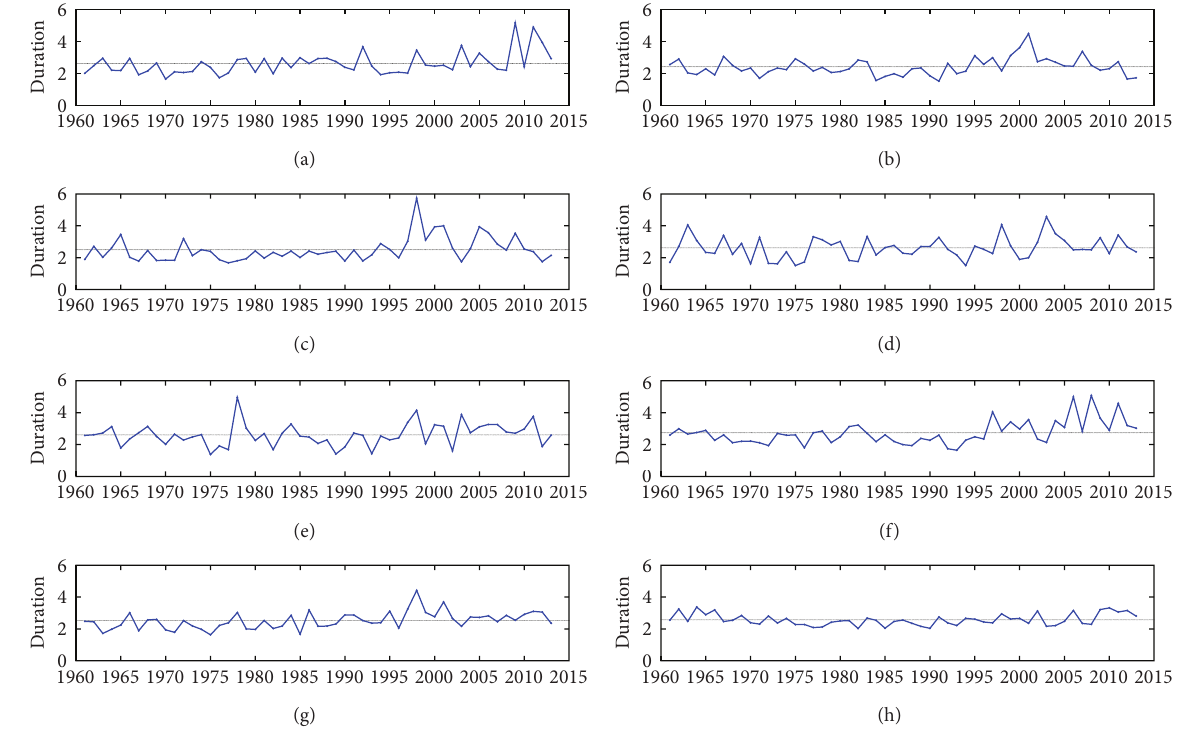
Figure 5: Temporal variation of drought duration in eight regions: (a) SW; (b) NE; (c) N; (d) SE; (e) YR; (f) NW; (g) C; (h) TP.